Question: What does this figure show? Answer in one sentence.
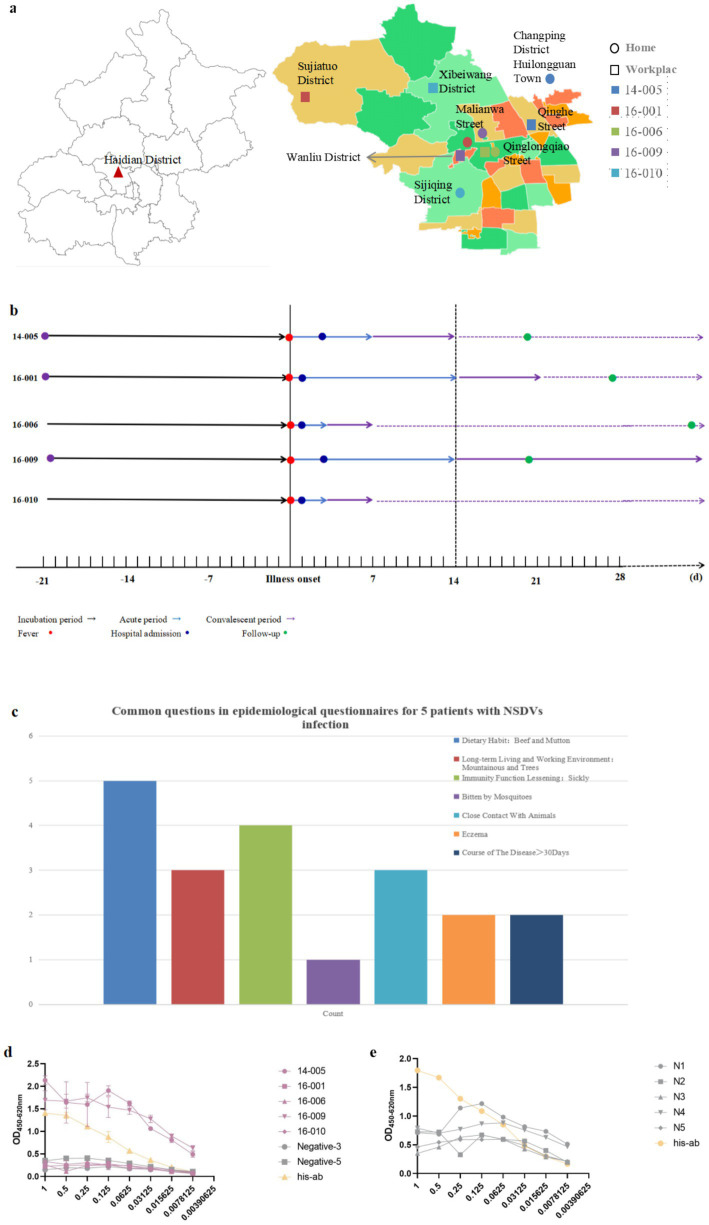
Answer: Activity trajectory and timeline of patients with NSDV infection and serological validation. (a) The distribution of life and work of patients with NSDV infection detected in Haidian district of Beijing (China); (b) The investigation timeline of 5 patients with NSDV infection from discomfort symptoms to complete recovery; (c) Common questions of the epidemiological questionnaire in 5 patients with NSDV infection; (d) The expression of serum NSDV antibodies in 5 patients with NSDV infection detected by ELISA; (e) The expression of serum NSDV antibodies in healthy controls detected by ELISA.